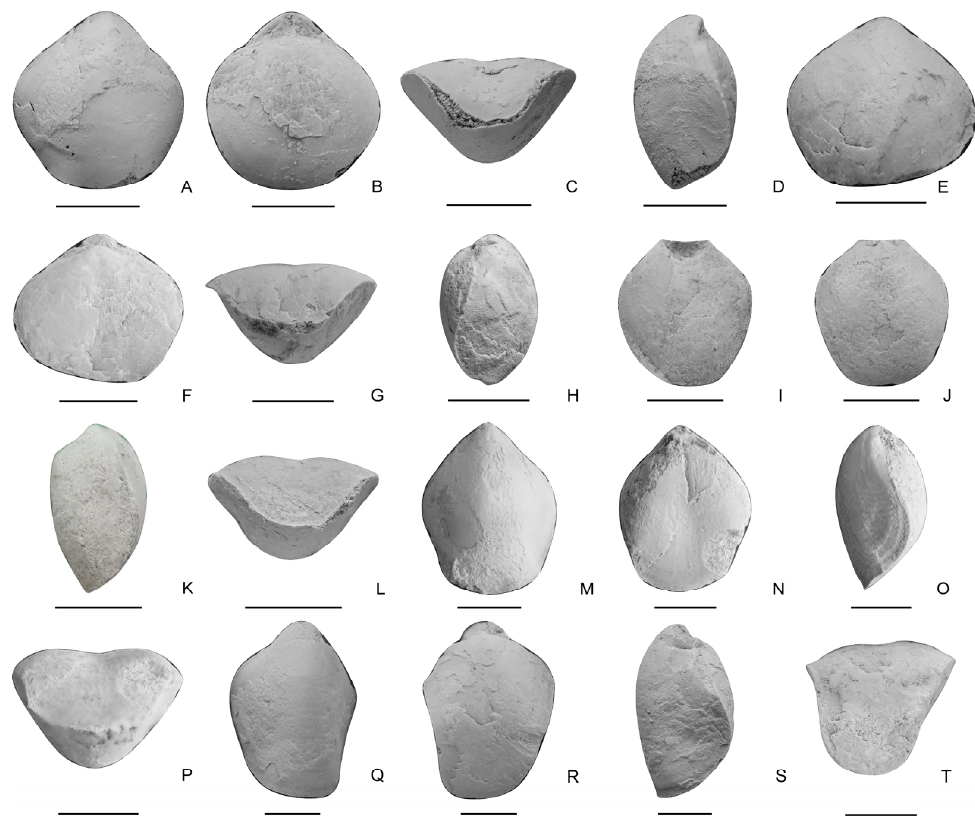
Figure 8. ( A – H ), Sulcatinella sulcata , ventral, dorsal, lateral and anterior views of two conjoined shells, LD384756, LD384786. ( I – T ), Sulcatinella elongata sp. nov., ventral, dorsal, lateral and anterior views of a conjoined shell, LD384755, LD384907, LD384867. Scale bar = 5 mm.